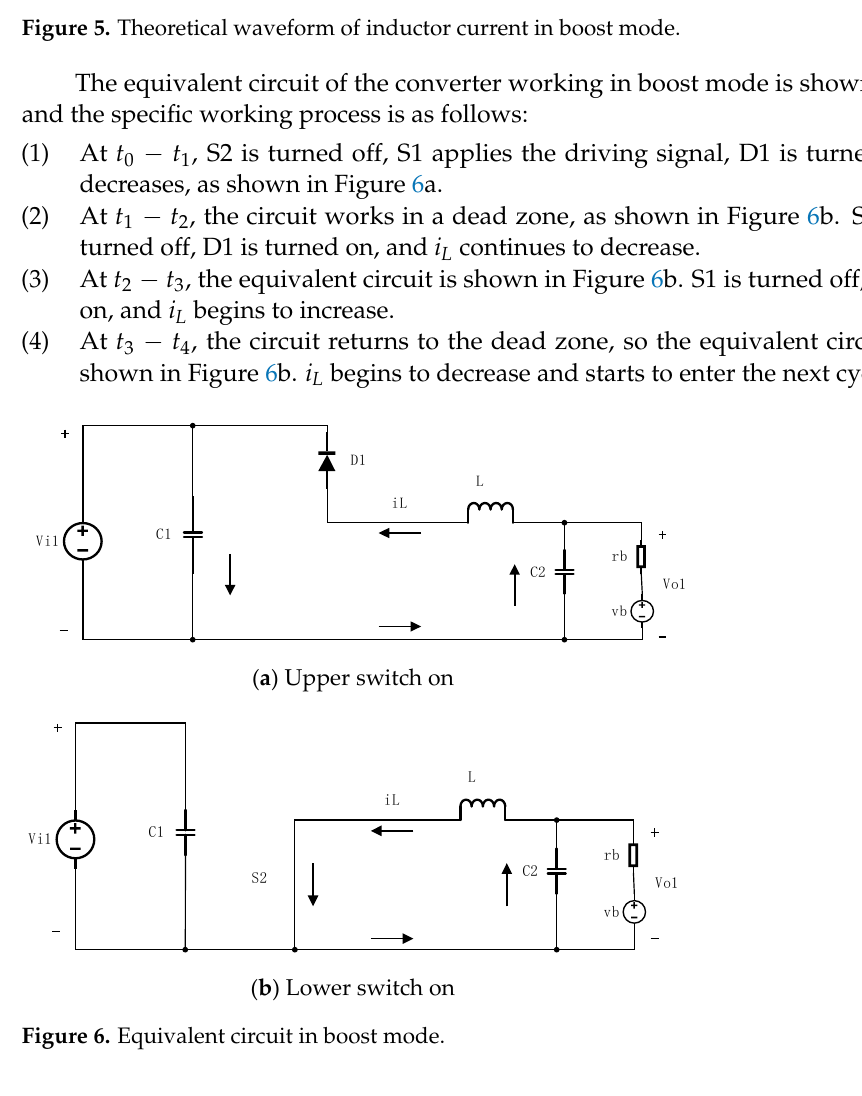
Figure 5. Theoretical waveform of inductor current in boost mode.